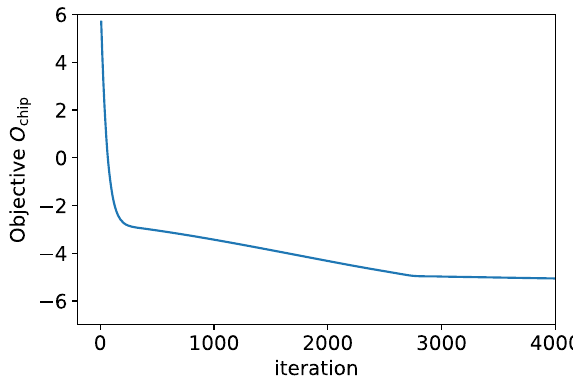
Fig. 5 Value of objective O chip during the optimization. O chip is de fi ned in Eq. (11). The curve is almost fl at after 3000 iterations. This suggests we have reached a local minimum or a region with small